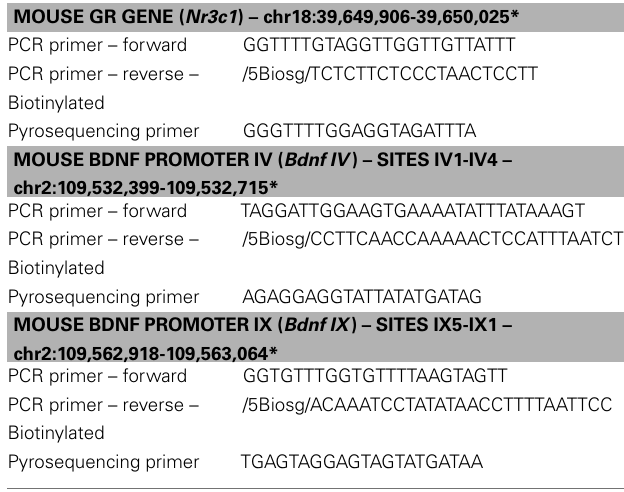
Table 5 | PCR and pyrosequencing primers used for DNA methylation